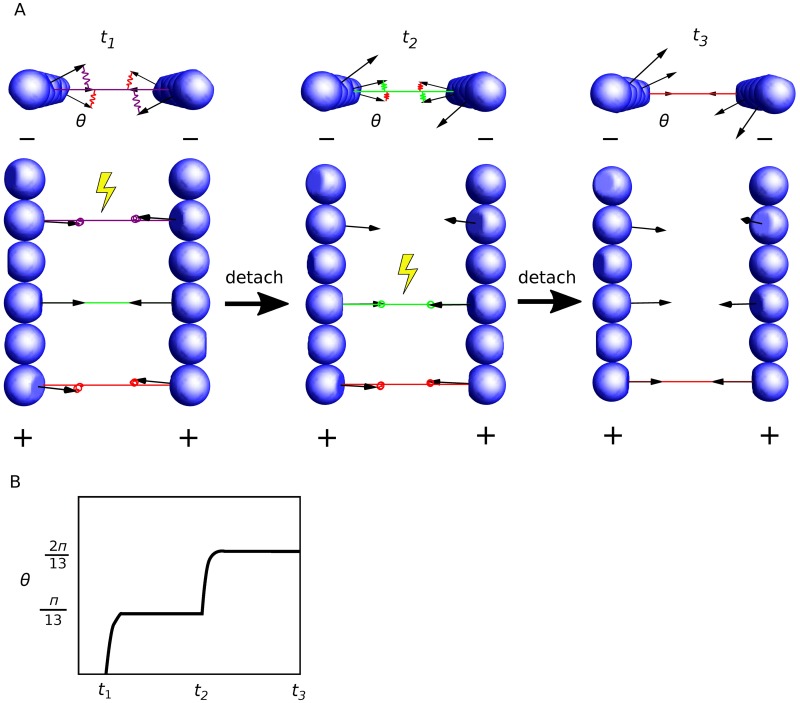
Schematic illustration of a possible mechanism for torque generation by sequential detachment of crosslinkers.(A) Two filaments in parallel are crosslinked on every other subunit. From left to right, crosslinkers are detached from the pointed end (−) to the barbed end (+) sequentially. Upon detachment of a crosslinker (yellow symbols), both filaments rotate around their axes counterclockwise. (B) The angular displacement of the filament upon every detachment is π/13.